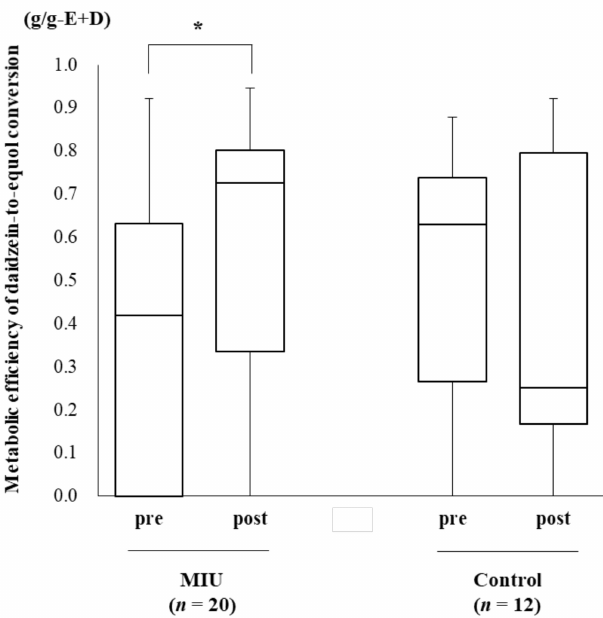
Figure 4. Effect of MIU or control water on the metabolic efficiency of daidzein-to-equol conversion throughout the intervention period. The metabolic efficiency of daidzein-to-equol conversion was significantly prompted in the MIU group. The top and bottom of each box indicate the 25th and 75th percentiles, and the solid line within the box is the median. Whiskers depict the minimum and maximum values. pre, preintervention; post, postintervention, * p <